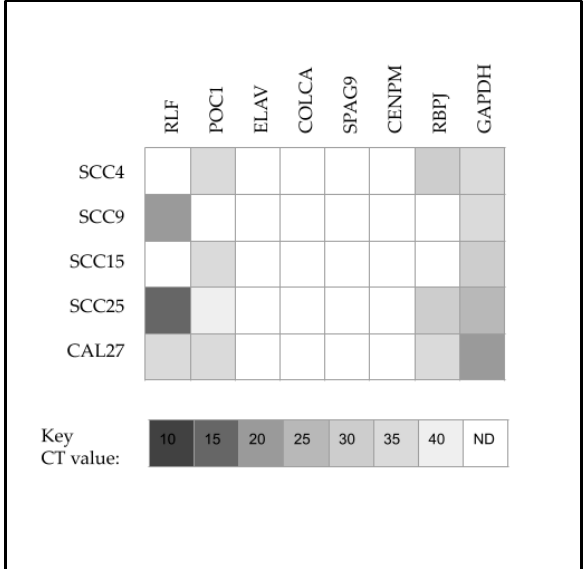
Figure 5. Screening of predicted downstream targets for miR ‐ 375. All cell lines expressed the positive control GAPDH cells with none of the cell lines expressing ELAV, COLCA, SPAG9 or CENPM. Differential expression was observed with RLF (SCC9 and SCC25 highly expressing), POC1 (SCC9 and SCC25 not expressing) and RBPJ.